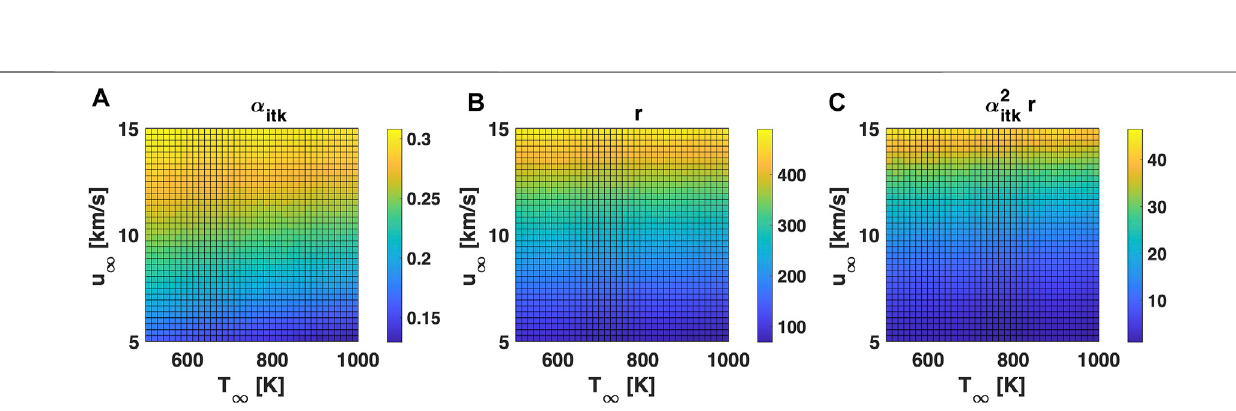
Frontiers in Physics |